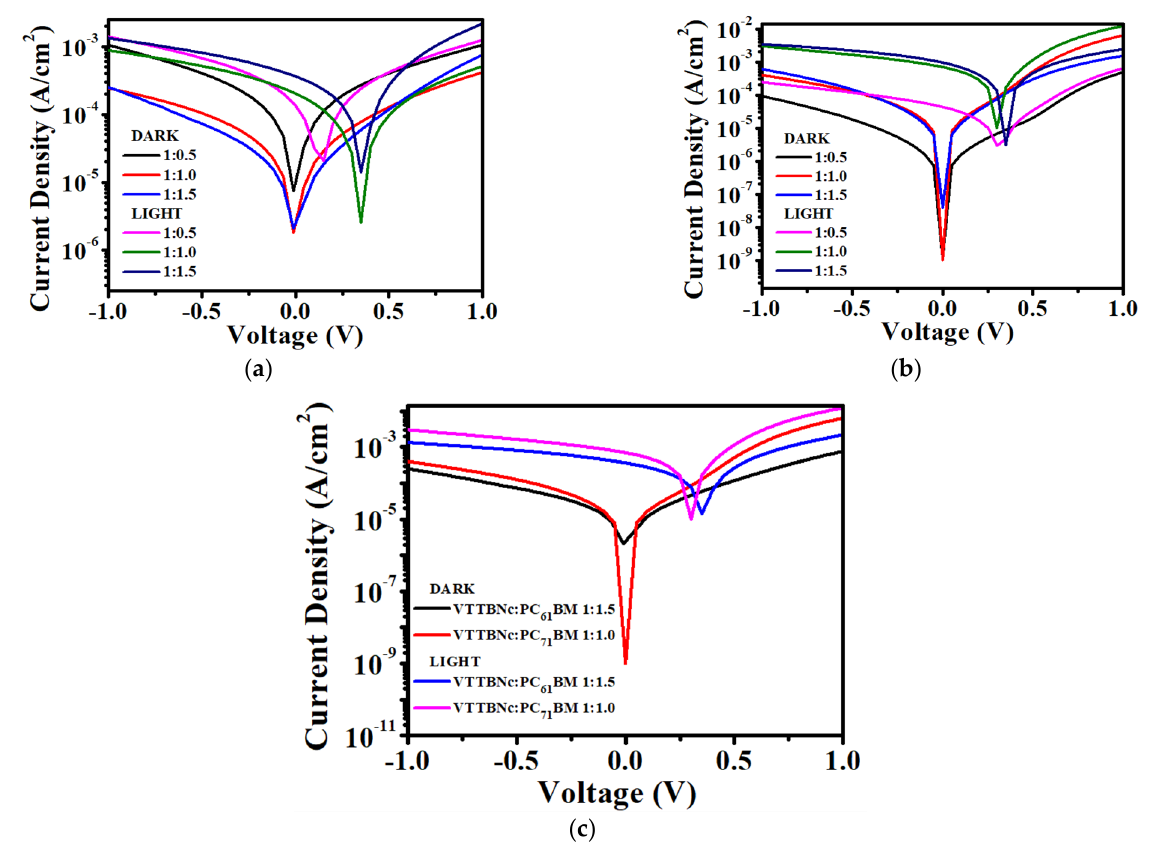
Figure 7. J–V characteristics of ( a ) VTTBNc:PC 61 BM and ( b ) VTTBNc:PC 71 BM of different ratios. J–V characteristics of ( c ) VTTBNc:PC 61 BM and VTTBNc:PC 71 BM of the optimized ratios. Table 2. Performance of VTTBNc:PC 61 BM and VTTBNc:PC 71 BM as a photodiode. Table 1. Performance of PC 61 BM and PC 71 BM as a